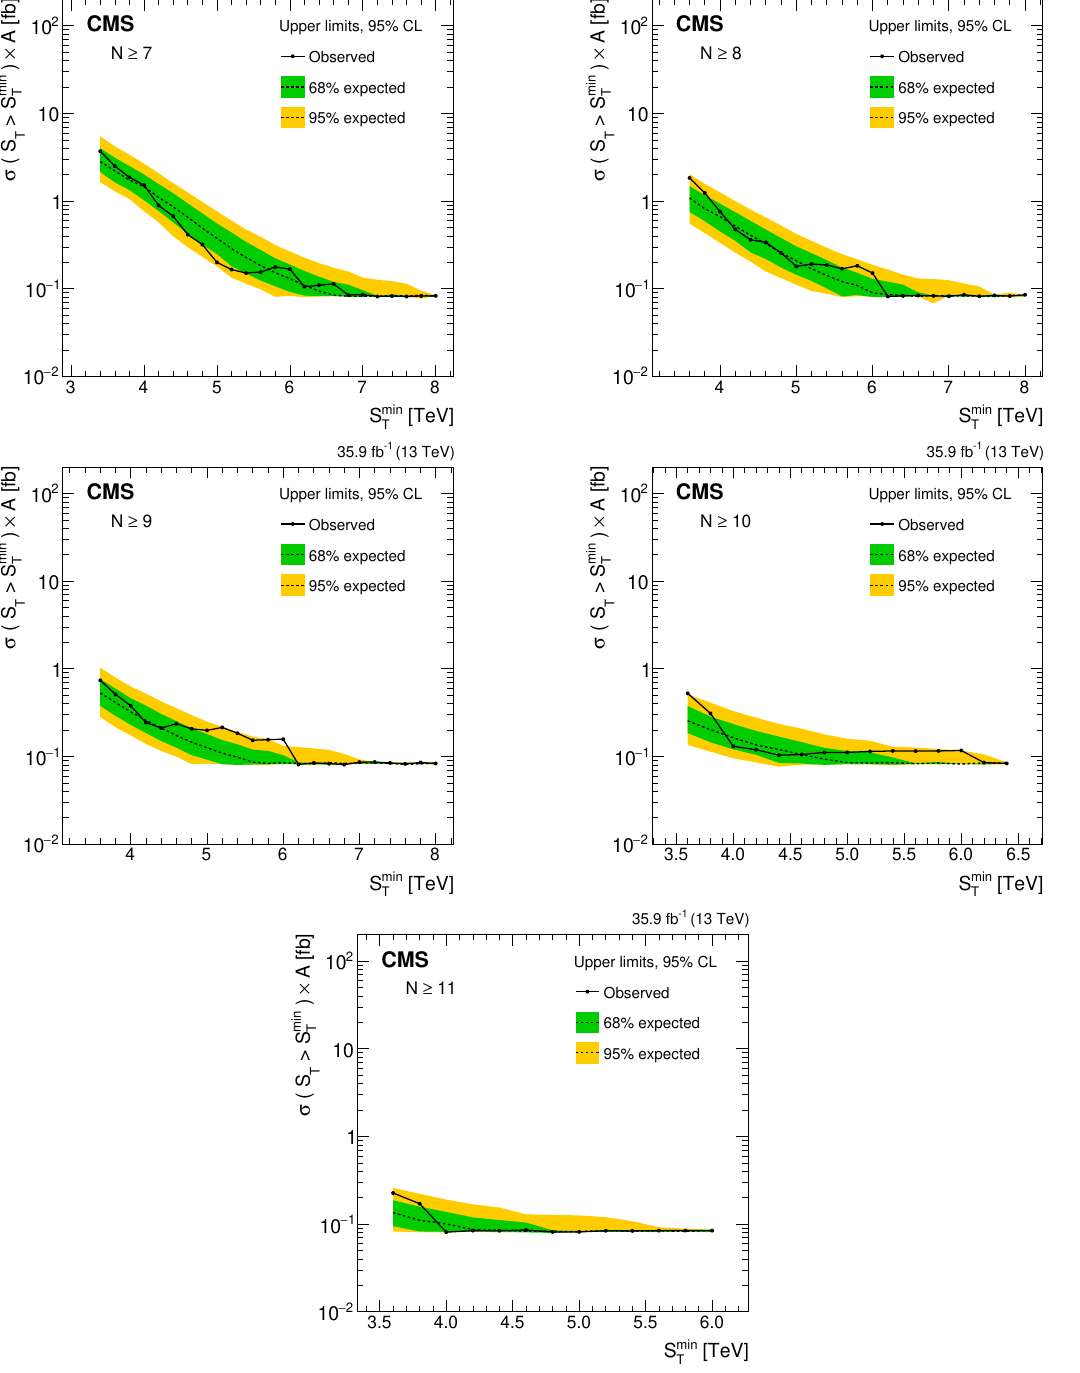
Figure 7 . Model-independent upper limits on the cross section times acceptance for (cid:12)ve sets of inclusive multiplicity thresholds, N (cid:21) 7 ; : : : ; 11 (left to right, upper to lower). Observed (expected) limits are shown as the black solid (dotted) lines. The inner (outer) band represents the (cid:6) 1 ( (cid:6) 2) standard deviation uncertainty in the expected limit.